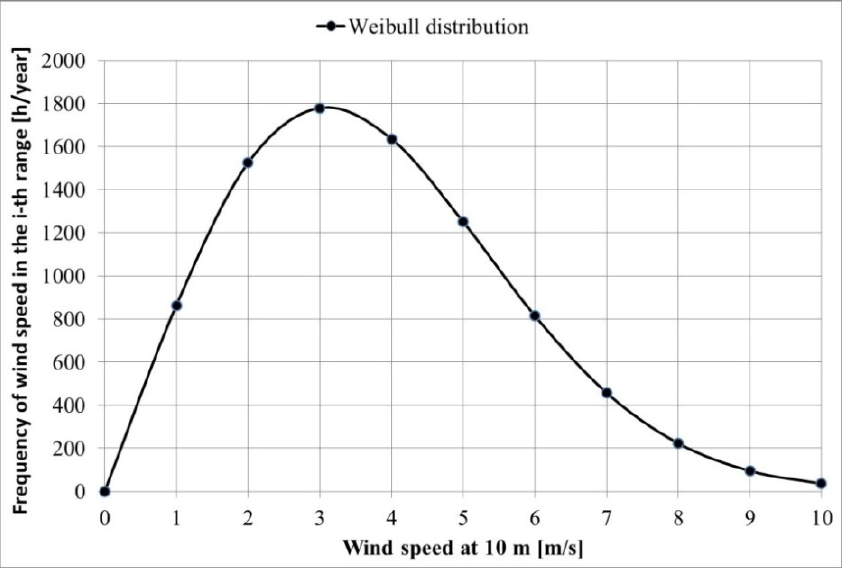
Figure 8. The Weibull distribution for the anemometer at 10 m above ground level for location IV.